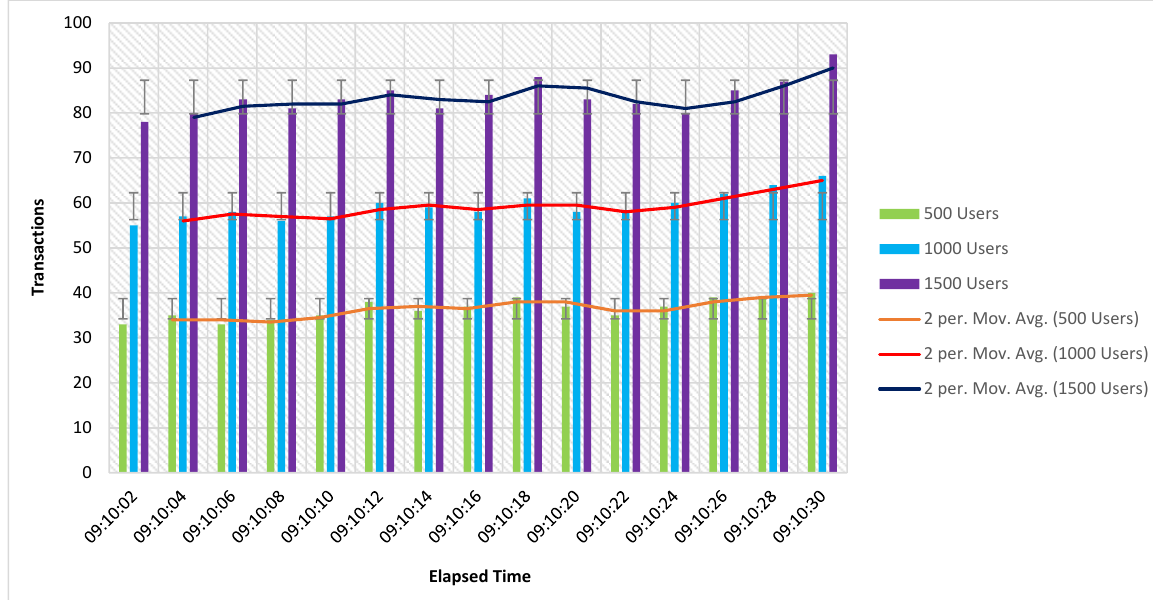
Figure 9. Per second transaction results using Hyperledger